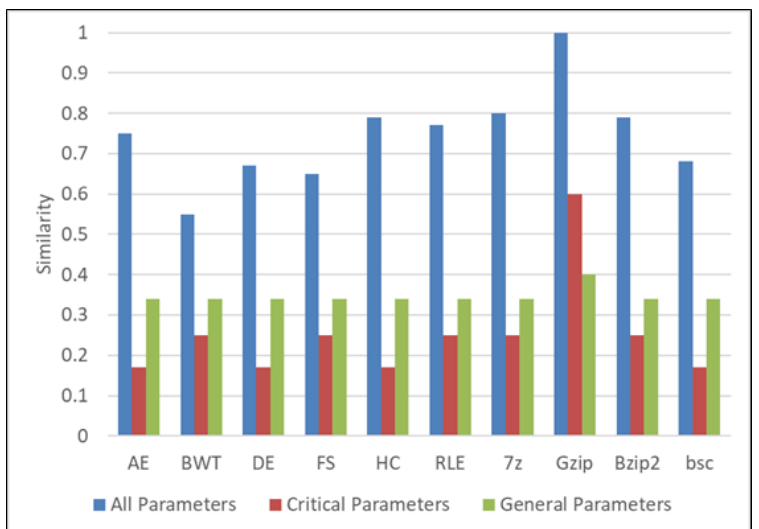
Figure 8. Similarity and weighting results of general-purpose algorithms. AE refers to Arithmetic Encoding, DE refers to Delta Encoding, HC refers to Huffman Coding, and RLE refers to Run Length